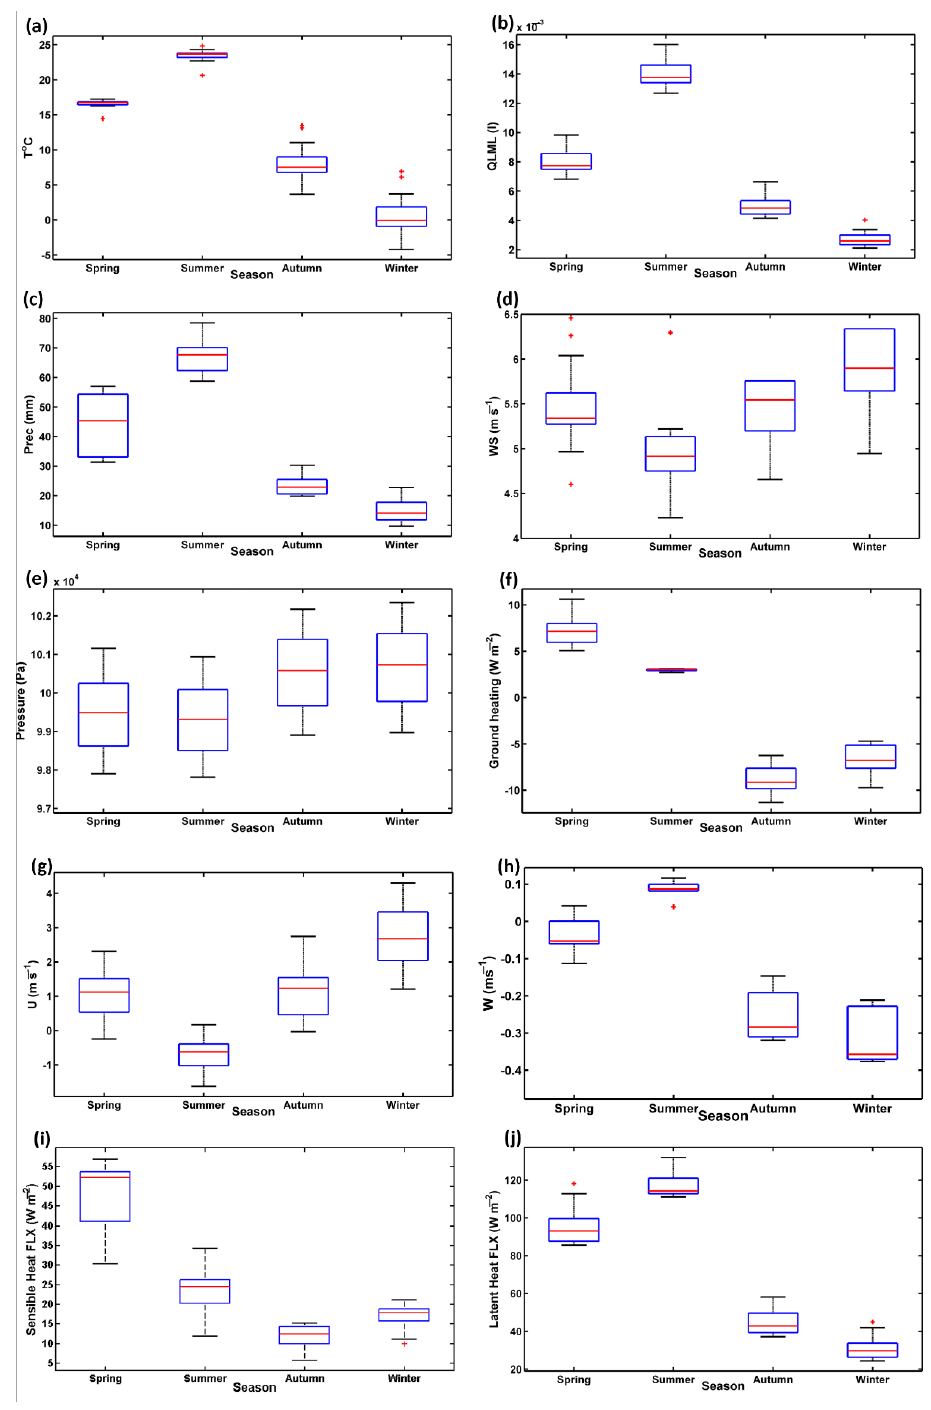
Figure 10. Seasonal variations of meteorological variables impacting air pollution in South Korea (2015–2020). The blue boxes represent the variations of the parameters, the lower and upper edges of the box are 25th and 75th percentiles, respectively, the red colored mark is the median, and the red plus symbols indicate outliers. ( a ) temperature, ( b ) specific humidity, ( c ) precipitation, ( d ) wind speed, ( e ) pressure, ( f ) ground heating, ( g ) horizontal (zonal) wind vector, ( h ) vertical wind vector, ( i ) sensible heat flux, and ( j ) latent heat flux.